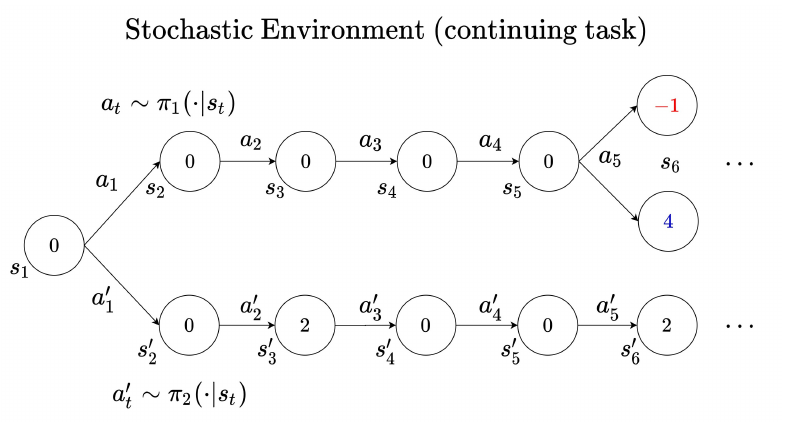
Figure 3. Example of trajectory in the environment with inherent uncertainty.